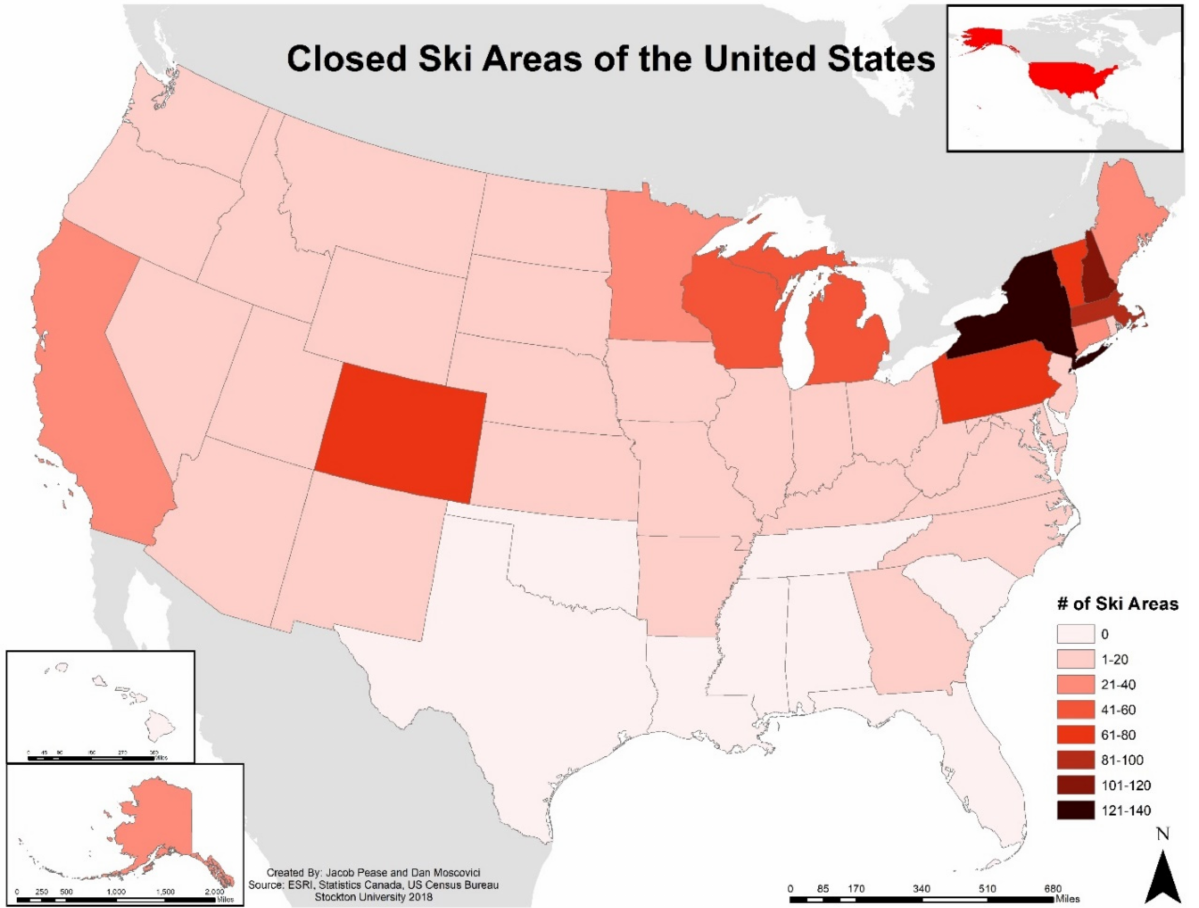
Figure 1. Number of ski resorts of the United States that were closed during the years